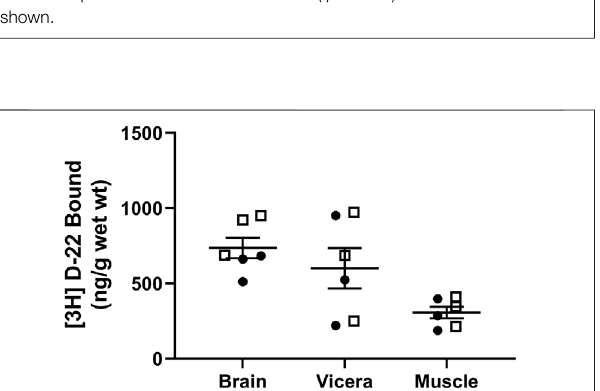
FIGURE 3 | was no effect of D-22 treatment or sex on top dwelling in the dive tank. (B) There was no effect of D-22 treatment or sex on exploration of the mazeasmeasured bylinecrossingsinthelight – darkplus maze. (C) Exposure to D-22 increased the percentage of white/total line crosses for female and male zebra fi sh (* p < 0.05). (D) D-22 treatment increased the time female zebra fi sh spent in white arms of the maze (* p < 0.05). Mean and S.E.M. are shown.